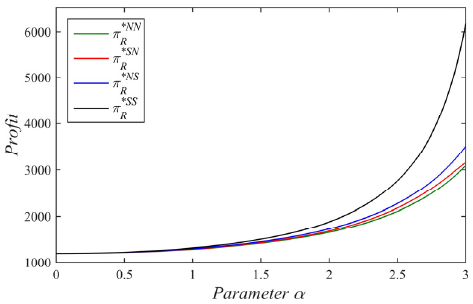
Figure 11. The impact of parameter α on the profits of retailer.